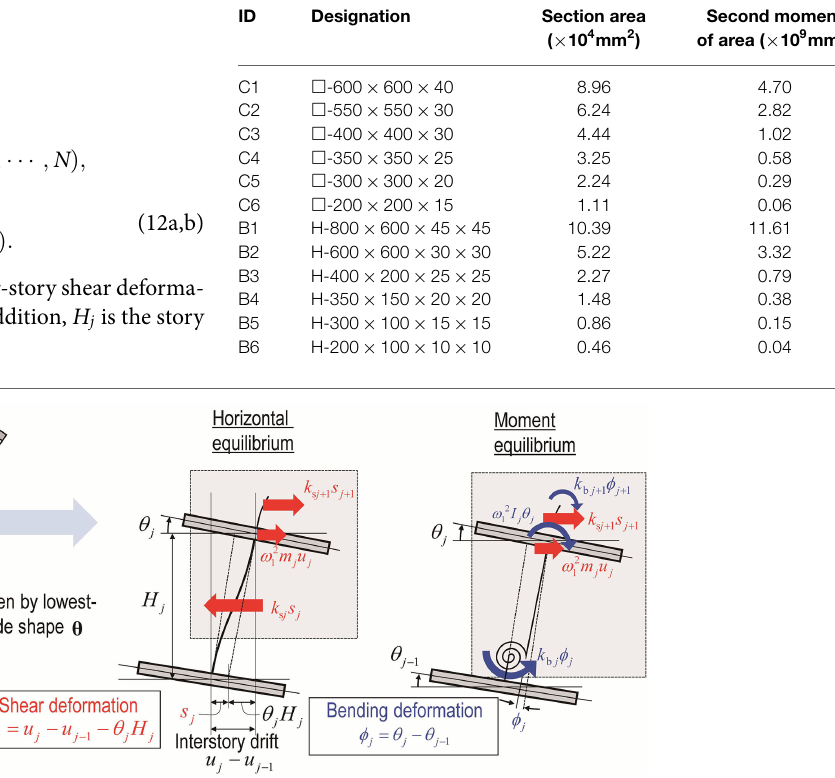
FIGURE 4 | Scheme of inverse-mode method for shear-bending